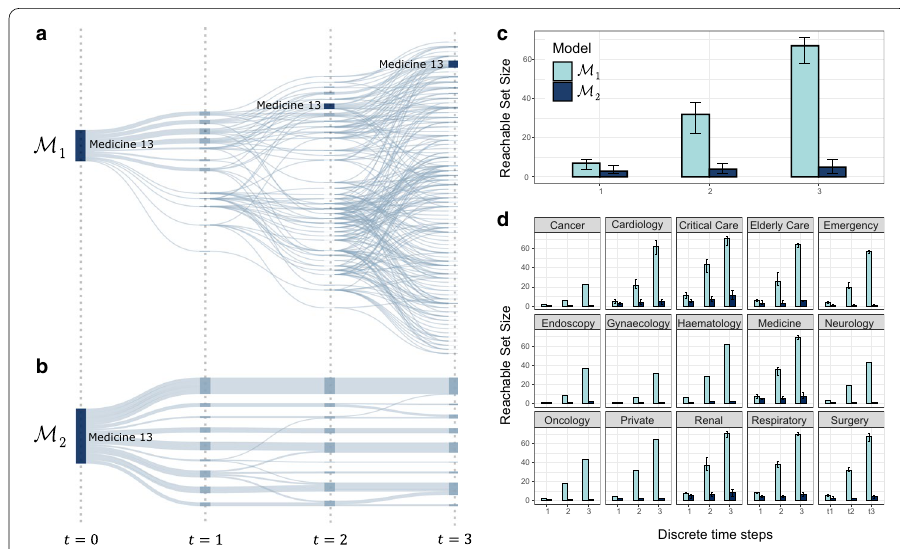
Fig. 4 Memory effects on network pathways. a , b A discrete random walk starting at Medicine 13 in the state networks of M 1 and M 2 , modelled as a discrete time diffusion over the transition matrices P 1 and P 2 respectively. After a single discrete time step t = 1 the reachable number of wards is similar between M 1 and M 2 , however, they quickly diverge as the diffusion evolves over time and the transitive effects increase in M 1 . c , d Median size of the reachable set of wards for M 1 and M 2 : c Overall reachability after t -discrete steps, and d reachability after t -discrete steps broken down by speciality (in the largest connected